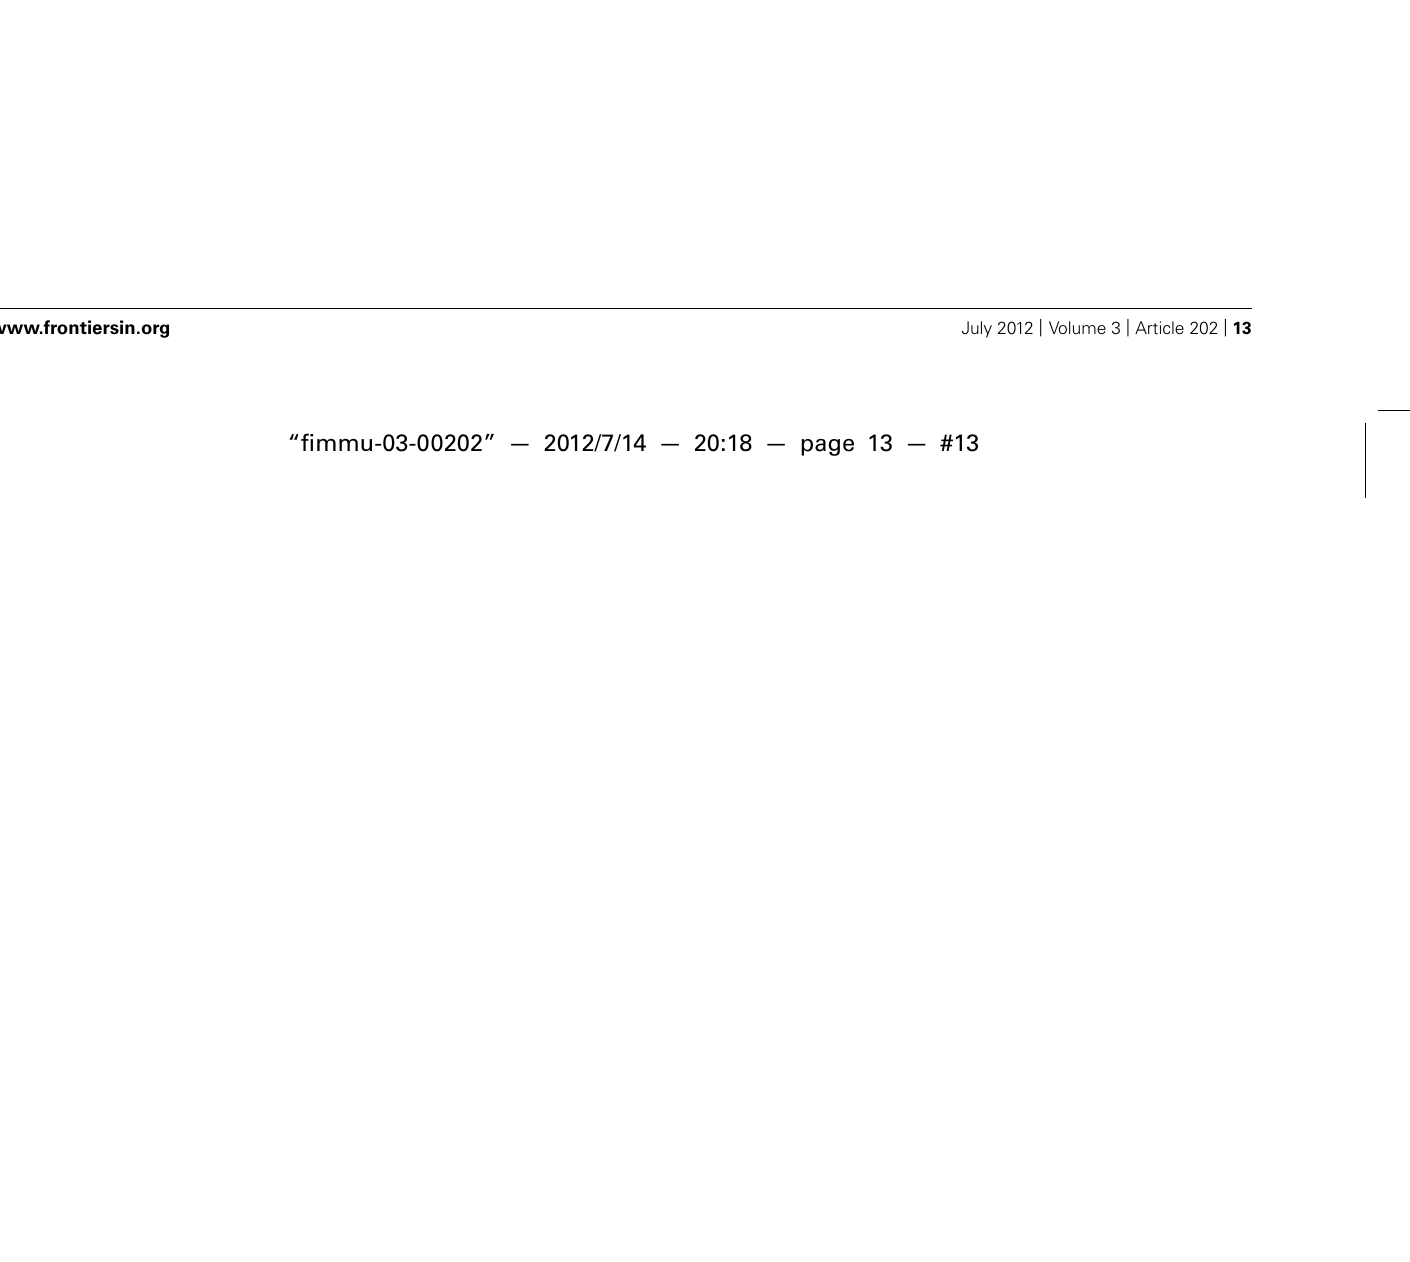
with the isotype control antibody (black bold line). Both MSC types constitutively express MHC I, but not MHC II. Data were collected using a BD FACS Canto II flow cytometer analyzed using FlowJo